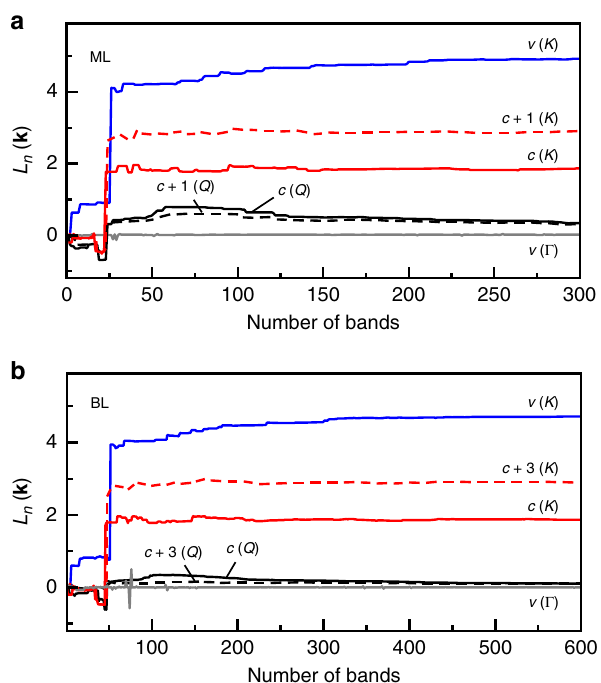
Fig. 4 Electron orbital angular momentum in monolayer and bilayer WSe 2 from DFT. a , b Electron orbital angular momentum from DFT calculations for the highest valence bands at K and Γ and the lowest conduction bands at K and Q in monolayer and bilayer WSe 2 , respectively.